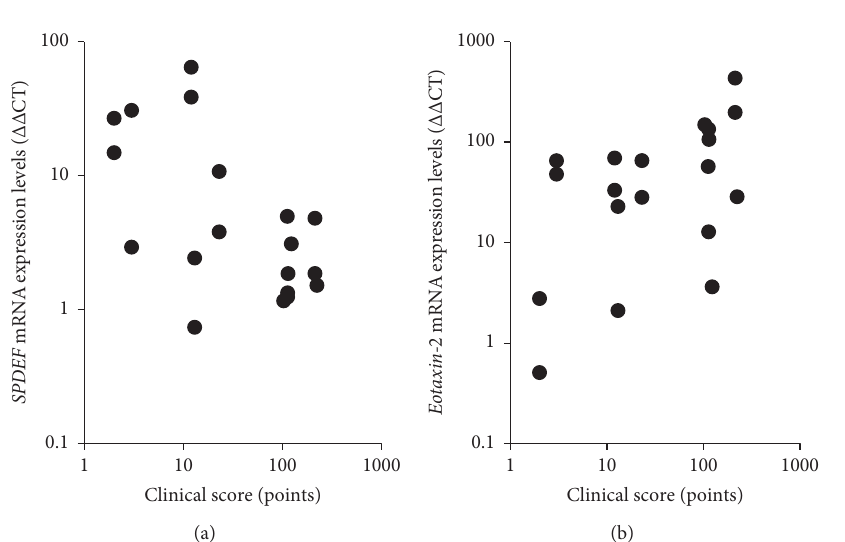
Figure 4: Correlations between clinical score and SPDEF mRNA expression and between clinical score and eotaxin-2 mRNA expression. Partial correlation coefficients showed significant correlations between clinical score and SPDEF mRNA expression levels (a) ( r �− 0.484, p � 0 . 049) and between clinical score and eotaxin-2 mRNA expression levels (b) ( r � 0.613, p � 0 .